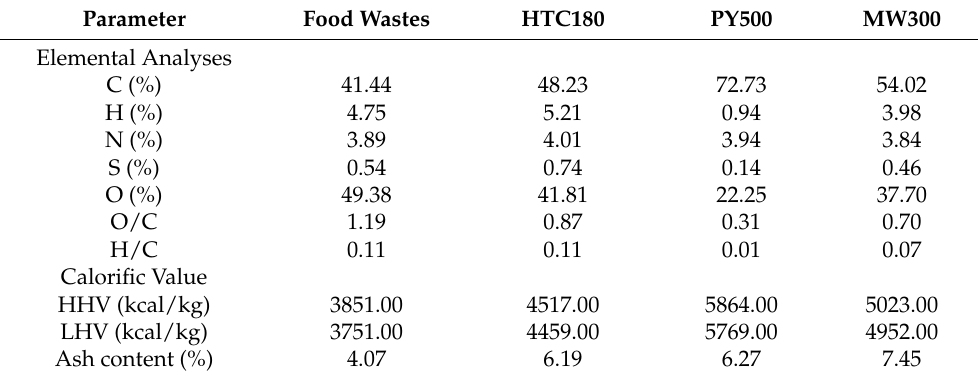
Table 1. Elemental and calorific values of food wastes mixture and chars with highest yield. Parameter Elemental